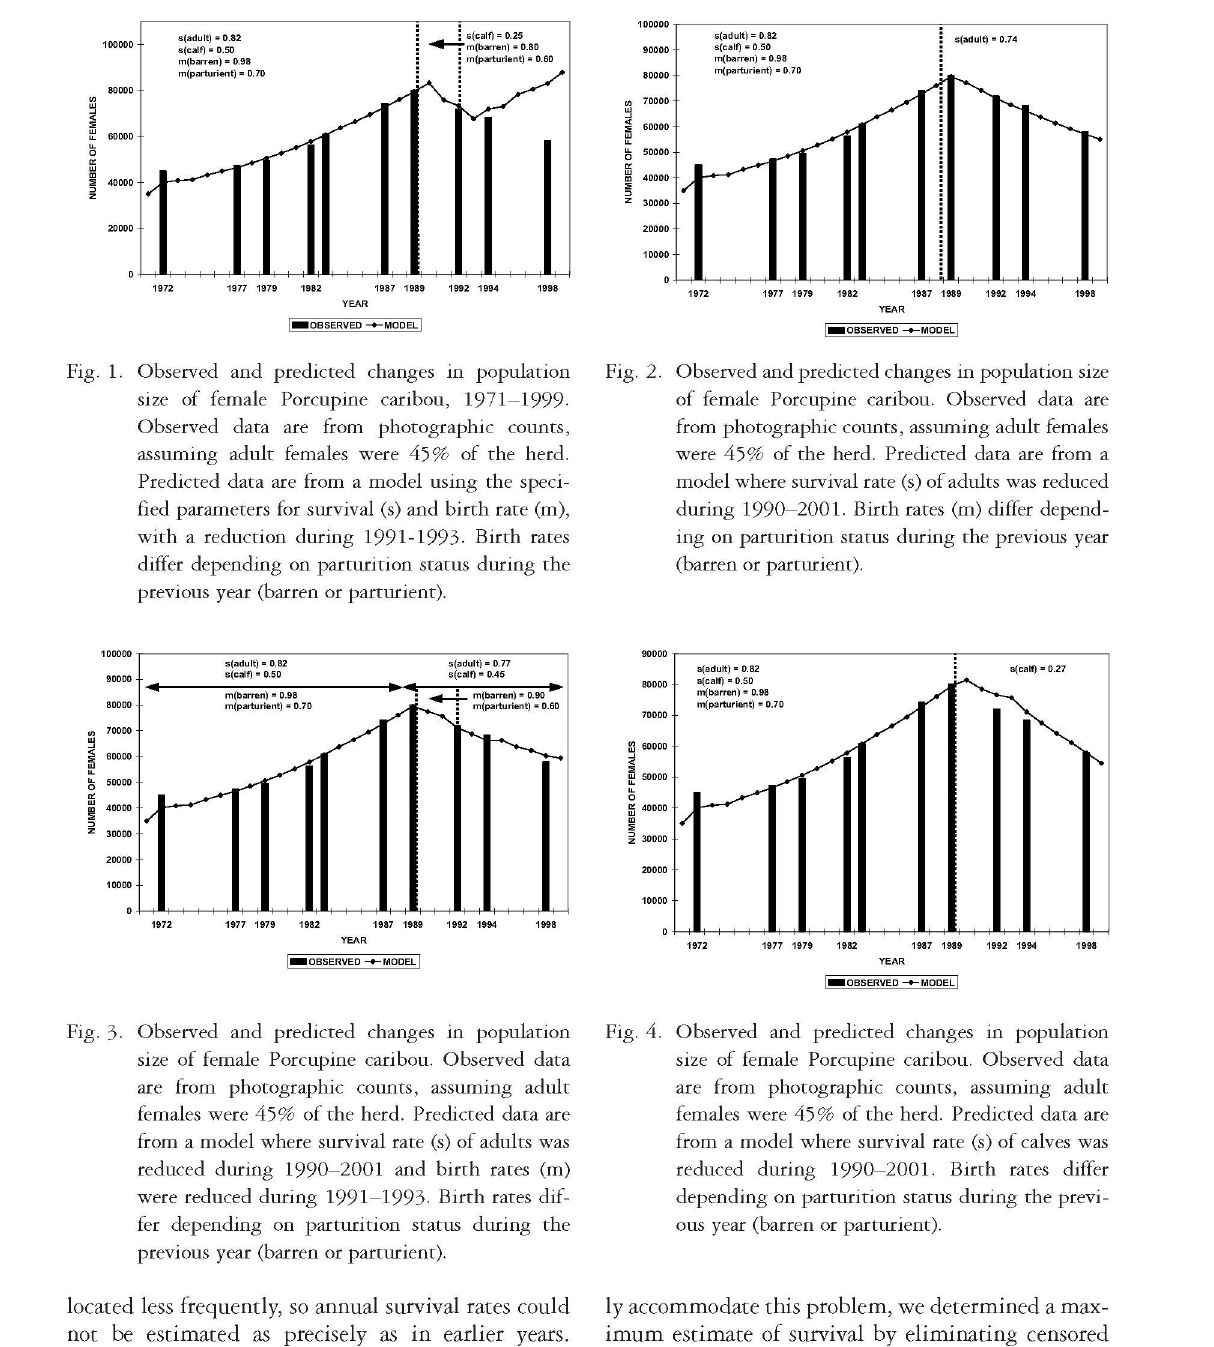
Fig. 3. Observed and predicted changes in population size of female Porcupine caribou. Observed data are from photographic counts, assuming adult females were 45% of the herd. Predicted data are from a model where survival rate (s) of adults was reduced during 1990-2001 and birth rates (m) were reduced during 1991-1993. Birth rates dif¬ fer depending on parturition status during the previous year (barren or parturient).